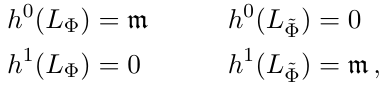
Z . An arrow marks point in region II discussed 2